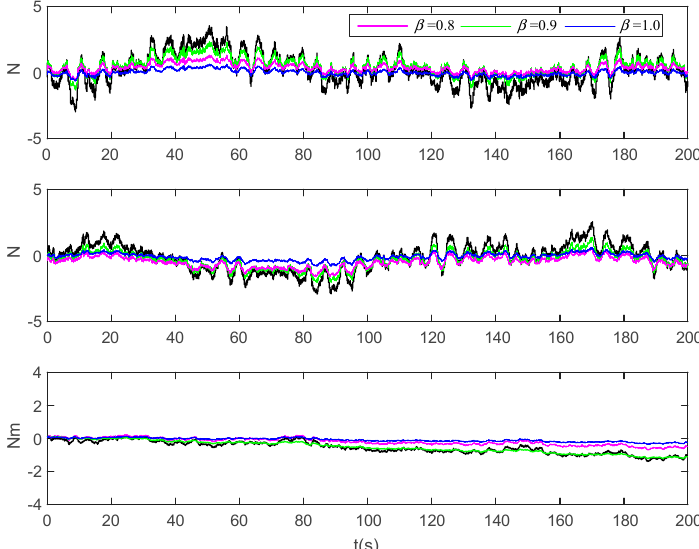
Figure 19. Disturbance observation results under different orders. Figure 20 shows the change curves of control force under different disturbances and different fractional orders. Similarly, it can be seen that when β = 0.8, β = 0.9 and β = 1.0, the control force of three-degree-of-freedom does not exceed their respective constraint range. However, when β = 0.9, the decreasing trend of the control force is faster than the other two orders, which also indicates that the observer can better compensate the system uncertainties when the order is 2.